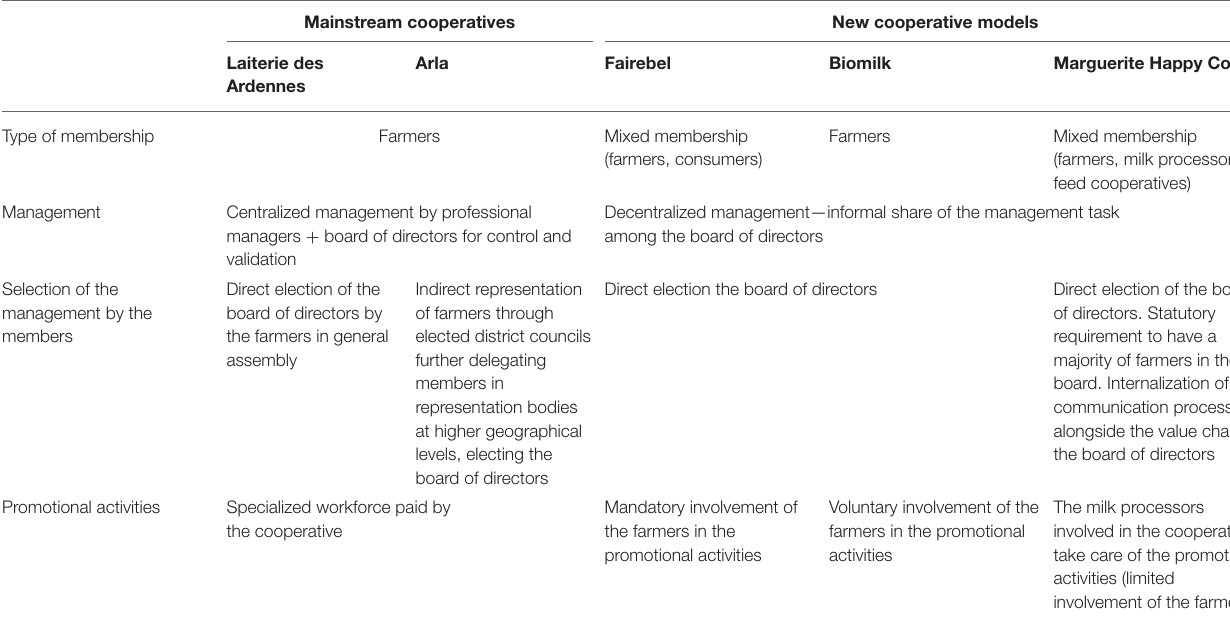
TABLE 4 | Summary of the governance features of the studied cooperative